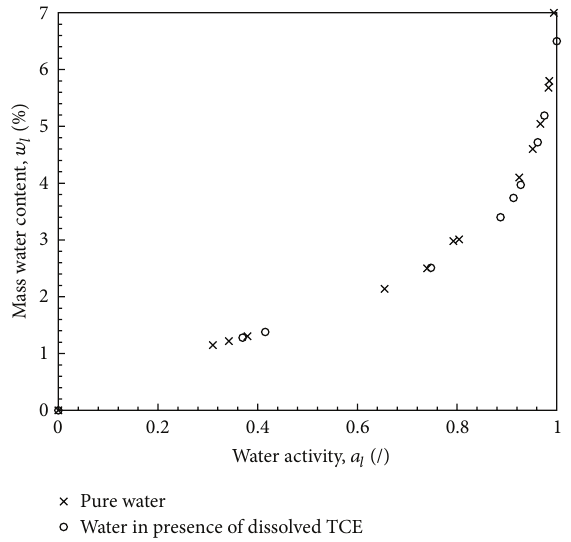
Figure 6: Comparison of water sorption isotherm curves deter- mined with and without the presence of dissolved